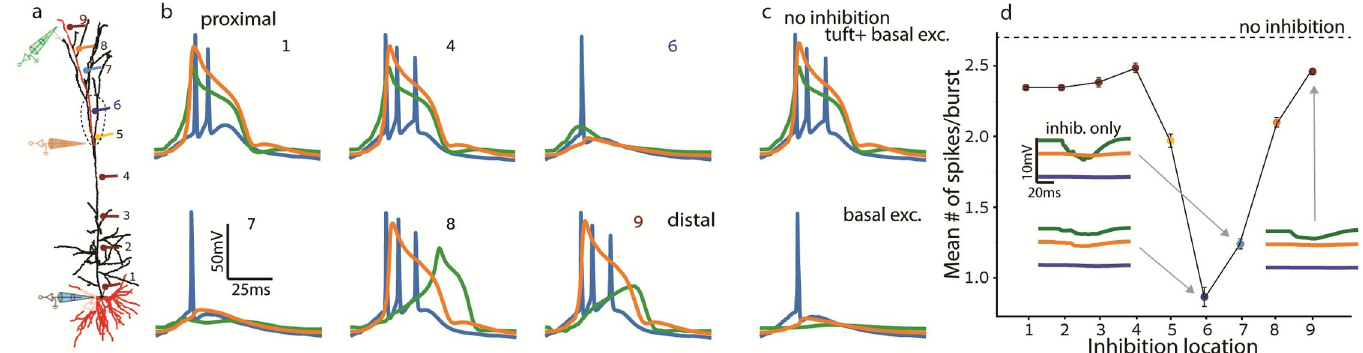
Fig 4. Inhibitory synapses edit the output burst differently depending on their dendritic location. The case of excitatory and inhibitory synapses restricted to a part of the apical tree. a. Model layer-5b thick-tufted pyramidal neuron as in Fig 1 A . Electrodes indicate locations of voltage recording. Red branches in both basal and apical trees receive distributed excitatory synapses. b. Voltage traces from a somatic (blue) and two dendritic electrodes (orange and green) shown in a , during the activation of inhibition in a single locus (1–9) in the apical trunk (1,4) and apical tuft (6–9), indexed as that of the synaptic location in a . Proximal dendritic inhibition at location (1) suppresses the first Na + spike (blue trace; compare to c , top trace) whereas inhibition at locations (6,7) abolishes the Ca 2+ spike (orange) and NMDA spikes (green) and, consequently, the latter two spikes in the burst. Distal inhibition (8–9) only attenuates the terminal-branch NMDA spikes (green trace) but does not significantly affect the Ca 2+ spike (orange trace) nor the somatic burst. c. Voltage traces without inhibition for basal and tuft excitation (top) and for basal-only excitation (bottom) for comparison. d. Mean # of spikes per burst as a function of location of inhibitory synapses (as in a ). In all cases 70 basal and 40 tuft excitatory synapses were activated simultaneously ( Δ t = 0) with σ = 10 ms. For simulating inhibitory input, 20 inhibitory synapses were uniformly distributed up to 100 μ m from each location (1–9) as marked in a ; the peak conductance per inhibitory synapse was 1 nS (see Methods ). Inset: Voltage traces of inhibition alone, in locations 6, 7 and 9, as pointed by the